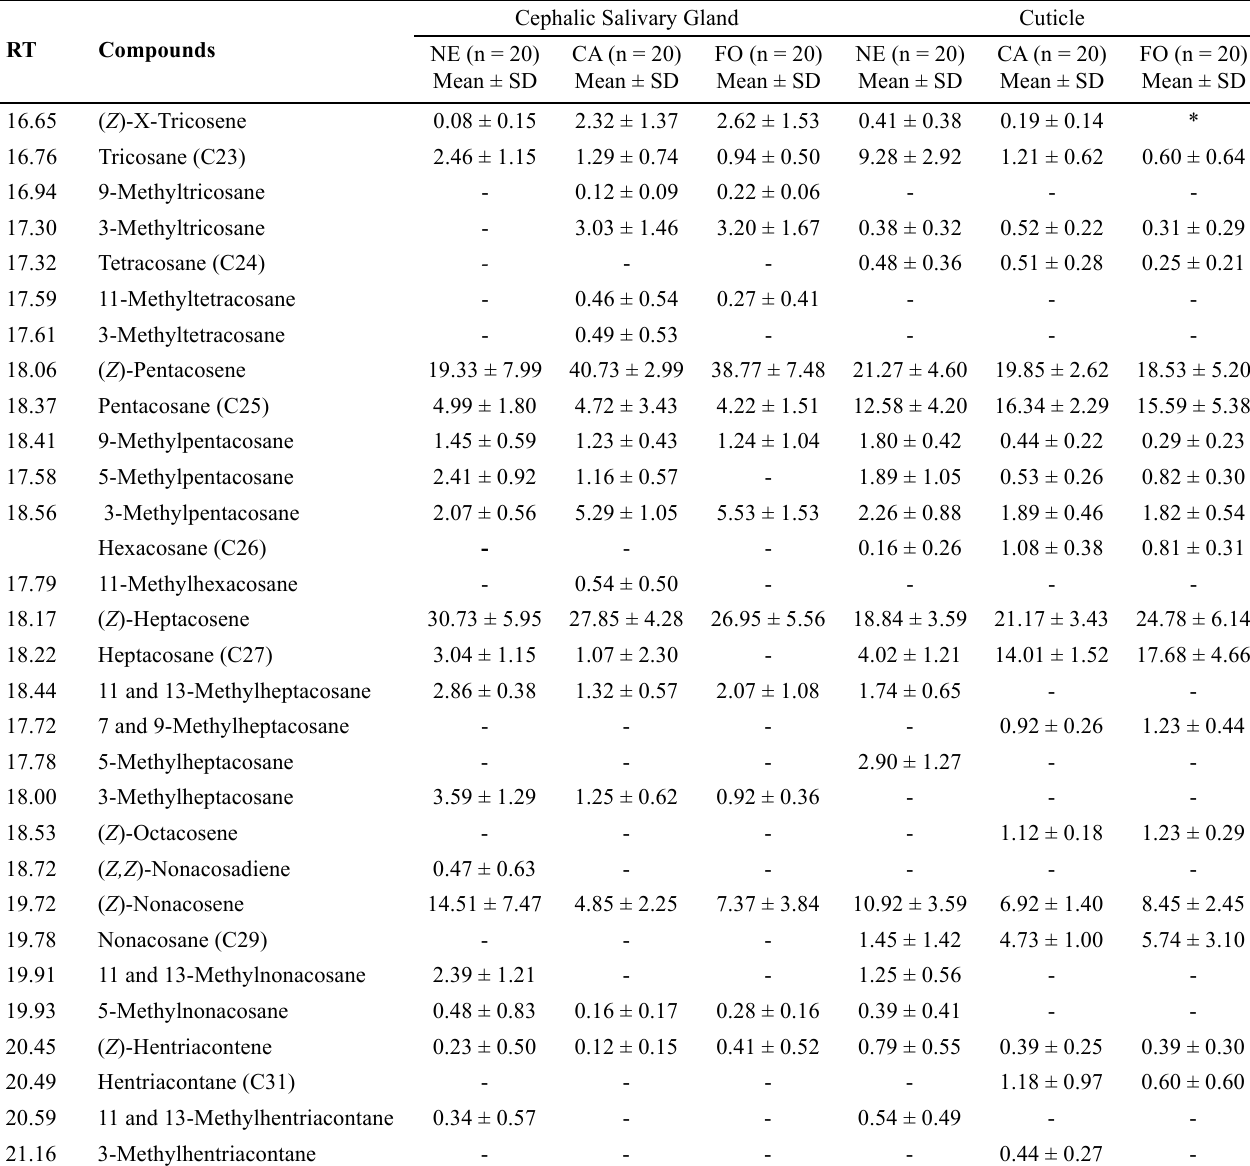
Table 1 . Mean and standard deviation (SD) of relative concentration (%) of the compounds from cephalic salivary gland secretion and cuticle of workers of Melipona quadrifasciata .